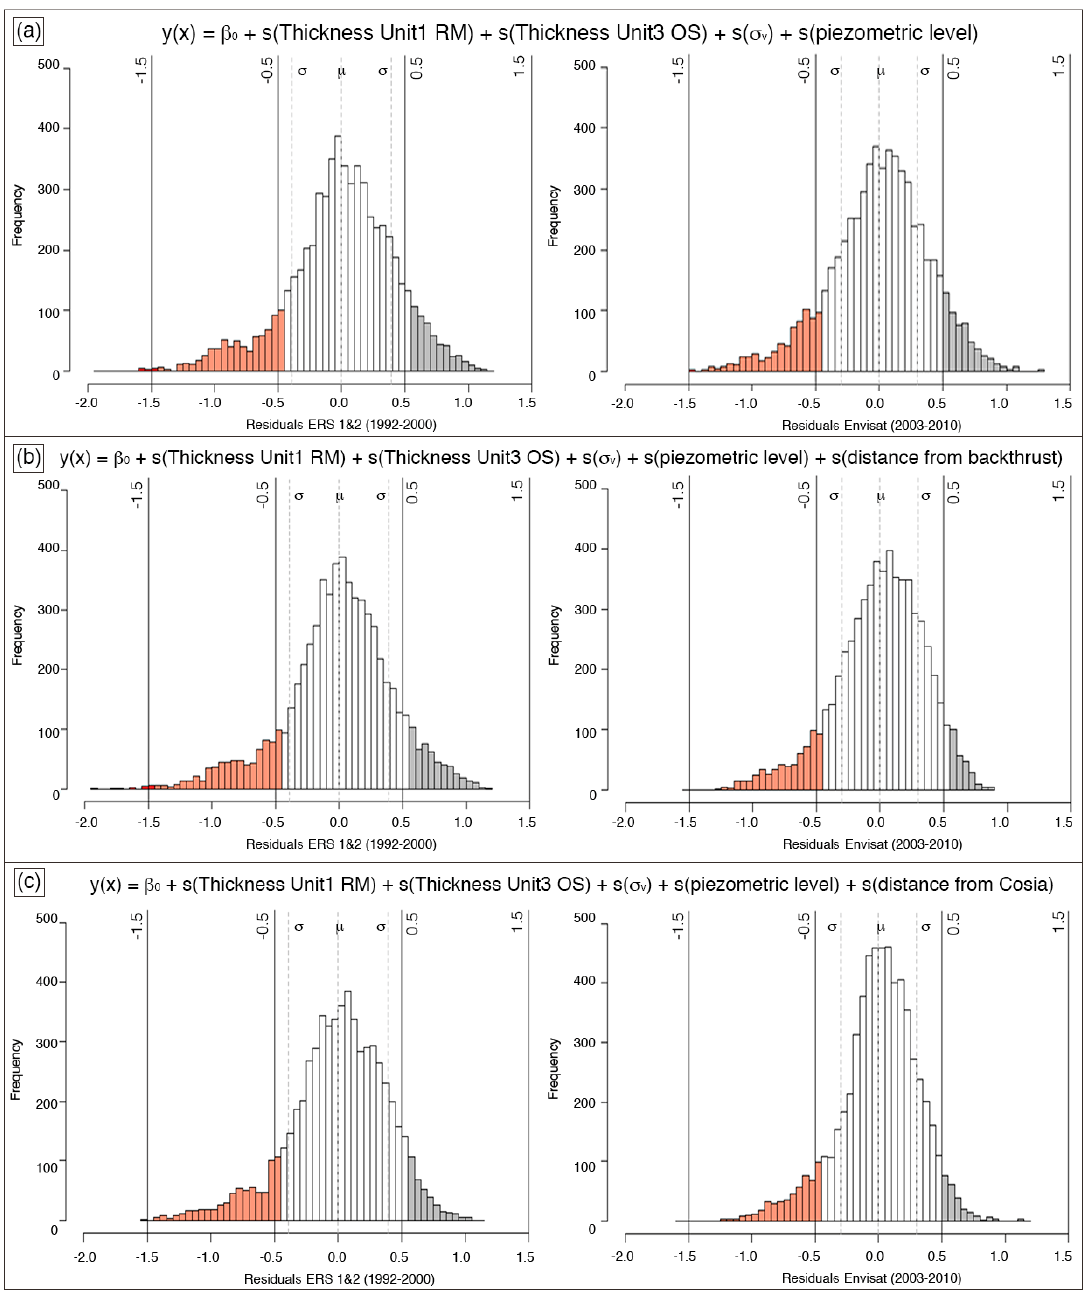
Figure 8. Histograms of GAM residuals for ERS 1 and 2 (1992–2000) and Envisat (2003–2010) models with the following predictors: ( a ) thickness of unit 1 (RM), thickness of unit 3 (OS), overburden stress ( σ v ), and piezometric level; ( b ) with the addition of the distance from the backthrust; ( c ) with the addition of the distance from Cosia stream.